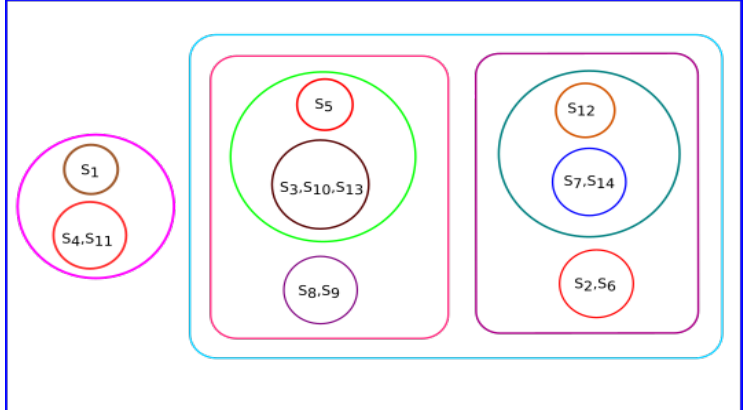
Figure 18. Clusters drawn from Hierarchical clustering phylogenetic tree based on Shannon entropy. Here, S i indicates the species name as specified in Table